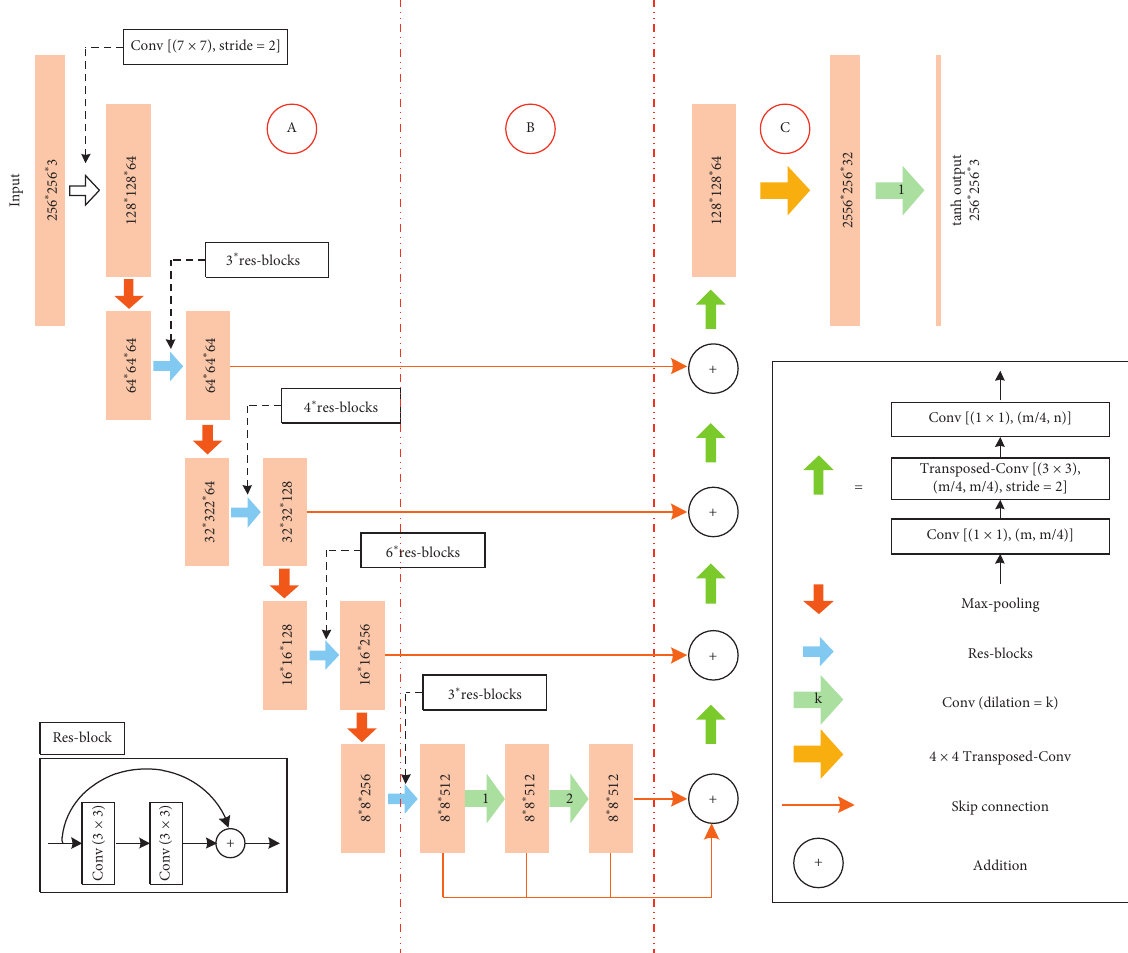
Figure 3: A diagram of D-LinkNet. Each orange rectangular block represents a multichannel features map. Part A and Part C are the encoder and the decoder of D-LinkNet, respectively. Here, D-LinkNet uses ResNet34 as encoder.